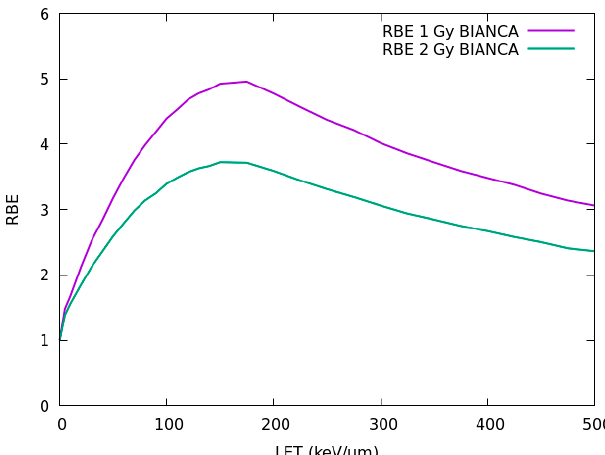
Figure 1. Relative biological effectiveness–Linear Energy Transfer (RBE-LET) relationship calculated by BIANCA for chordoma cell survival following irradiation with monochromatic carbon beams at 1 Gy (upper curve) or 2 Gy (lower curve) Carbon dose.